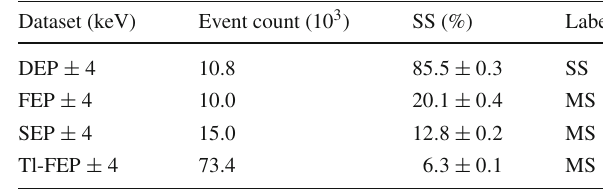
Table 1 Overview of the energy-based datasets and associated SS and MS classification including event count and SS fraction with